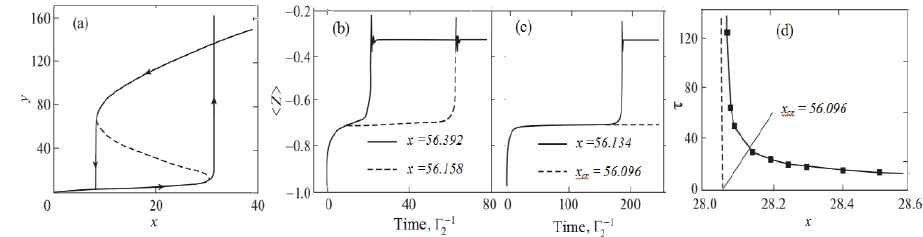
Fig. 1. (a) – Optical hysteresis of the field intensity y =| Ω | 2 /( Γ 1 Γ 2 ) inside the slab, obtained Under adiabatically sweeping the external field intensity x = Ω 02 /( Γ 1 Γ 2 ) up and down (shown by arrows). The parameters of calculations are : Δ L = 20Γ 2 , kL = 0.1, Δ 0 = - 5Γ 2 , Γ 1 = 2Γ 2 , Γ 2* = 0.5Γ 2 . (b) and (c) – Time evolution of the integrated population difference ‹ Z › after an abrupt switching of the external field intensity x from zero to a value that exceeds the critical intensity x cr = (Ω 0cr ) 2 /(Γ 1 Γ 2 ) = 56.096 . The parameters of calculations are the same as in (a), except Γ 2* = 2Γ 2 . (d) – Intensity dependence of the switching time τ .